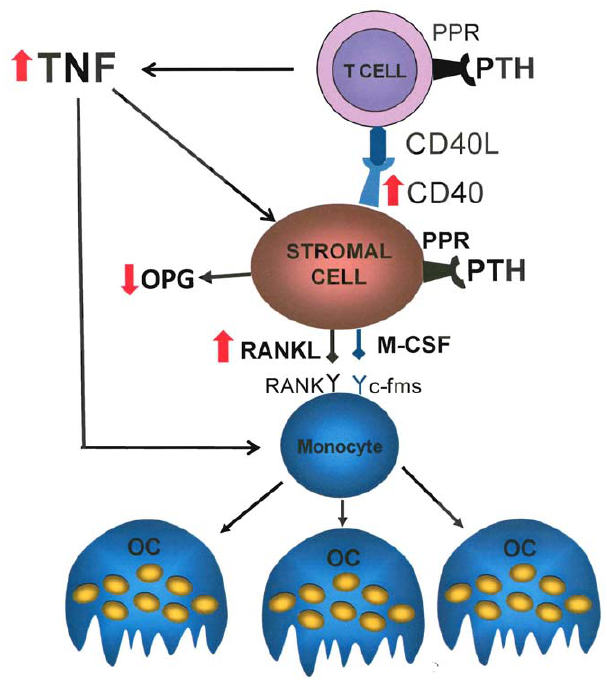
Figure 7. Schematic representation of the role of T cell PPR in cPTH stimulation of OC formation. PTH binding to PPR in T cells stimulates the production of TNF. This cytokine increases CD40 expression by SCs. Binding of CD40 by T cell expressed CD40L increases SC sensitivity to PTH resulting in enhanced SC production of RANKL and diminished secretion of OPG in response to PTH. T cell produced TNF further stimulates OC formation through its direct effects on maturing OC precursors. The red arrows represent the main modifications induced by activation of PPR signaling in T cells.